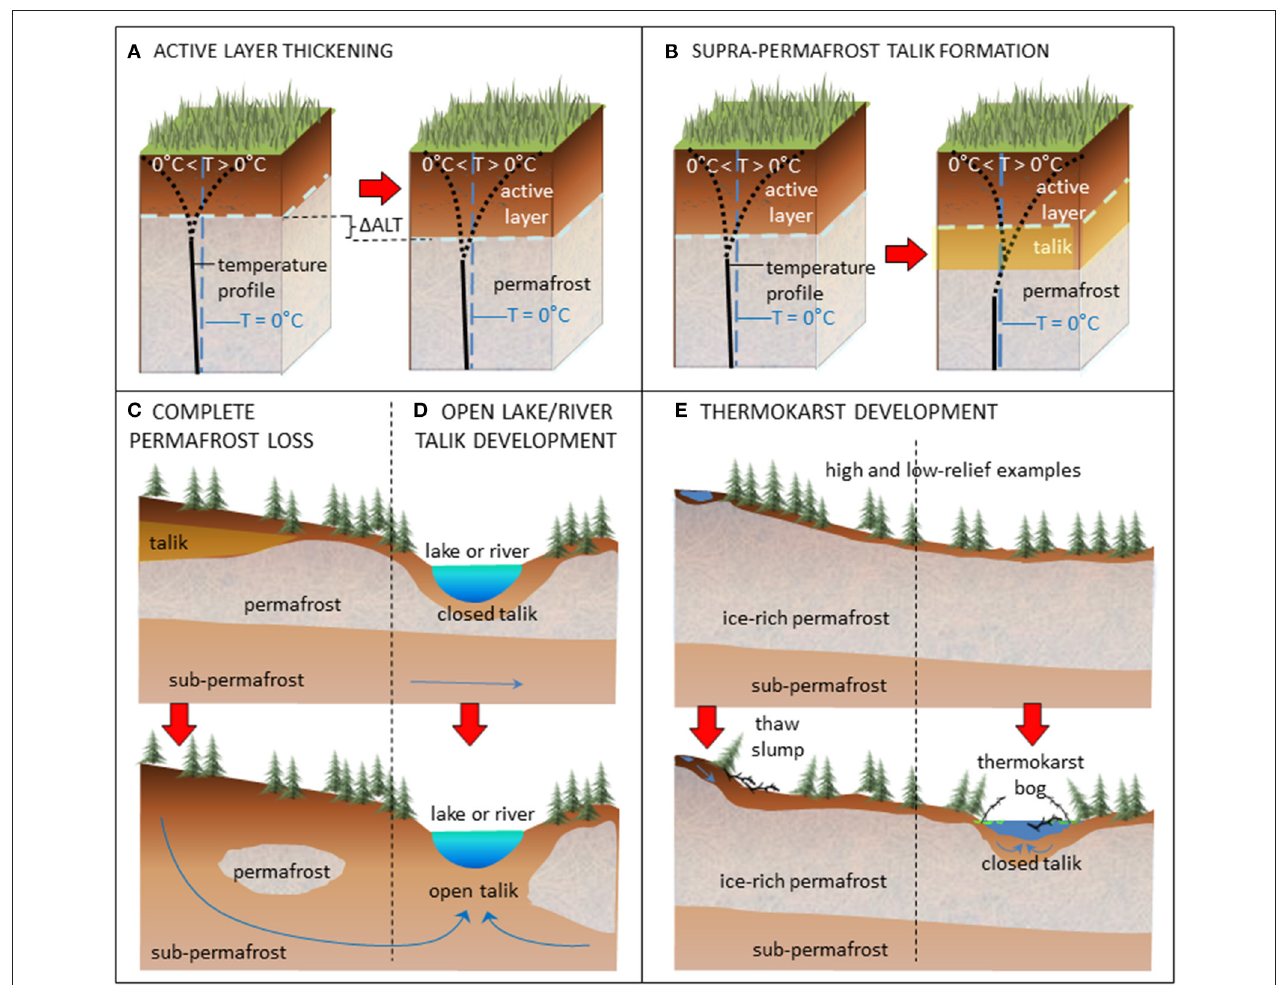
FIGURE 2 | Five primary modes of permafrost thaw (A–E) modified from Kurylyk and Walvoord (2021). Red arrows point in the direction of thaw evolution from one state (left or above) to the next (right or below). 1 ALT in (A) = change in active layer thickness. Blue arrows in (C–E) indicate the direction of subsurface water flow.